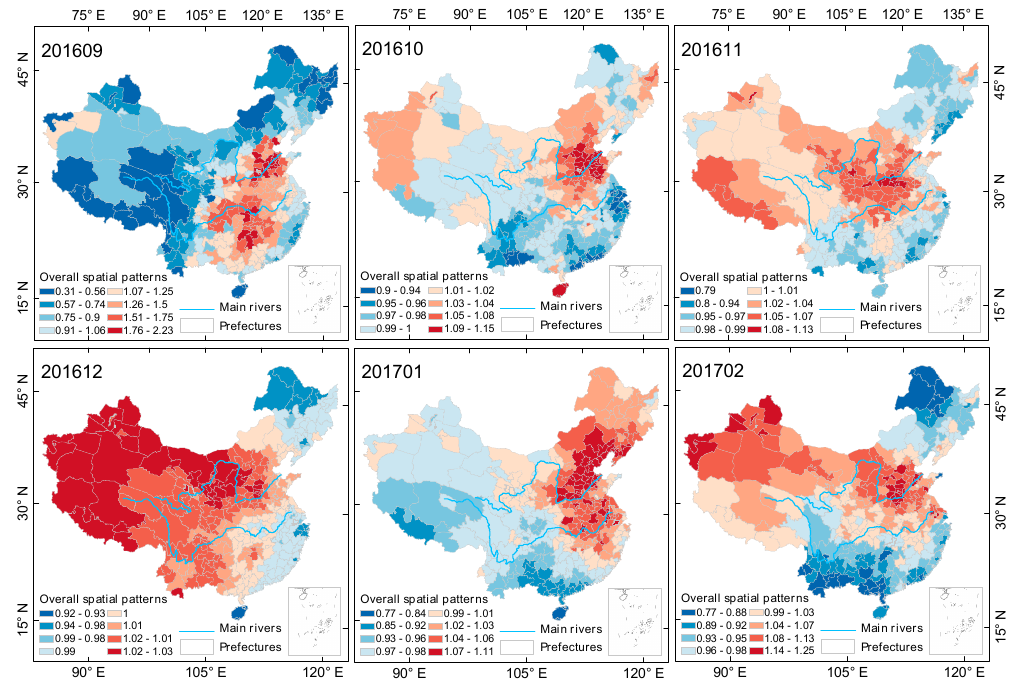
Figure 7. Evolution of spatial relativity of PM 2.5 pollution over the Chinese mainland (not including Taiwan) during the autumn ‐ winter season of 2016–2017. Specific to each autumn ‐ winter cycle, the spatial pattern of PM (cid:2870).(cid:2873) pollution in mainland China exhibits its own characteristics. In January 2015, February 2016 and December 2016, the spatial differences in PM (cid:2870).(cid:2873) pollution were smallest, and the corresponding maximum values of steady state